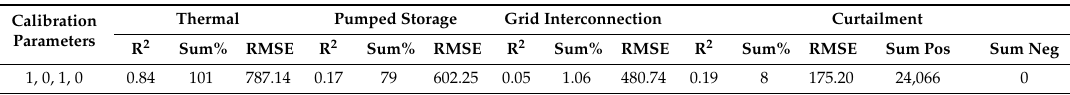
Table 5. Four window calibration parameters used and calibration results for supplies and curtailment as shown in Figure 8.